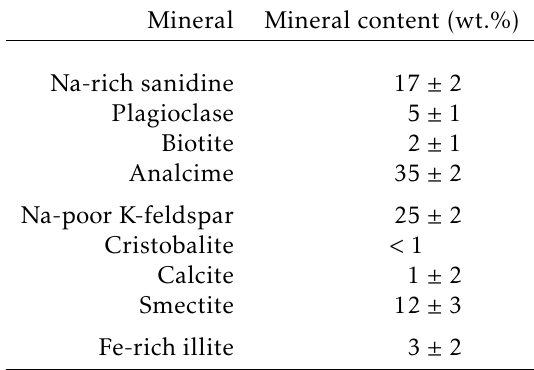
(Figure 3). Our XPRD analysis found no residual glass (Table 1). Microstructurally, the MEGT is very hetero- geneous and contains pores of various sizes (from a few tens of microns up to a few millimetres in diameter) (Figure 3) and large (often several millimetres long) al- tered porous fragments (Figure